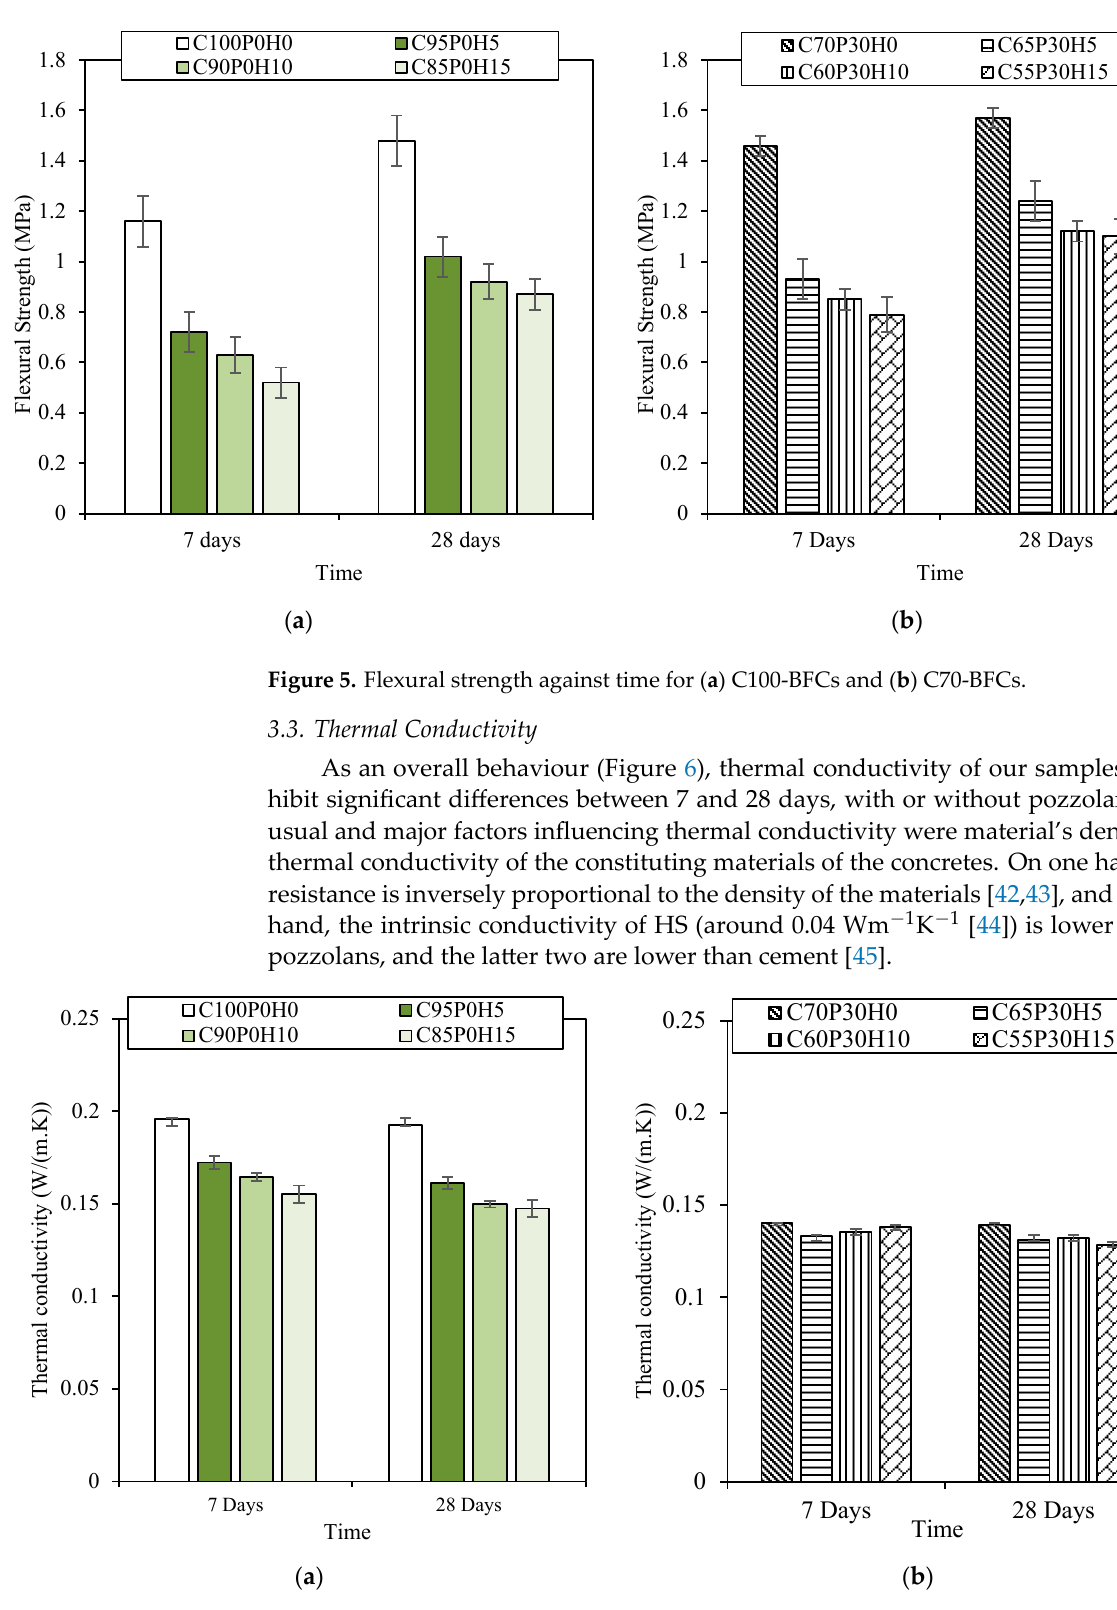
Figure 6. Thermal conductivity of all samples versus time for ( a ) C100-BFCs and ( b ) C70-BFCs.